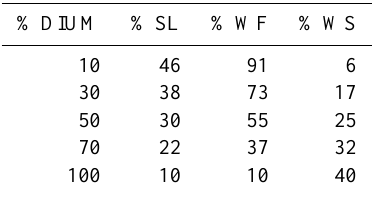
Figure 4. Irrigation scenarios depending on the plant available wa- ter (TAW). The average crop yield are based on a 3-year simulation period (see also Doorenbos and Kassam, 1979). Table 1. Results of five different scenarios DIUM (Drip Irriga- tion Under Mulch) with SL = spray loss, WF = Wetting Fraction, WS = Water